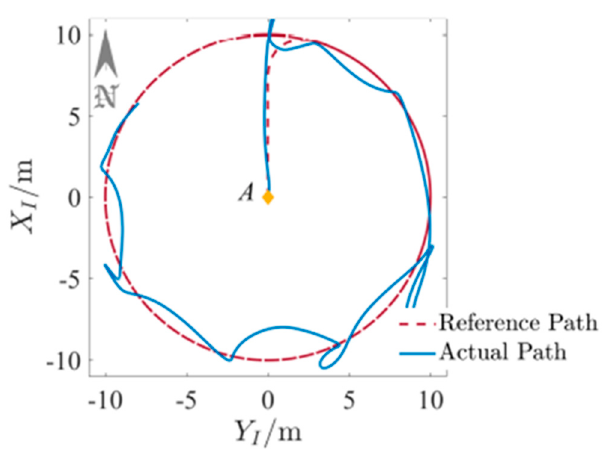
Figure 25. Route diagram of circular tracking based on the basic PID guidance law.